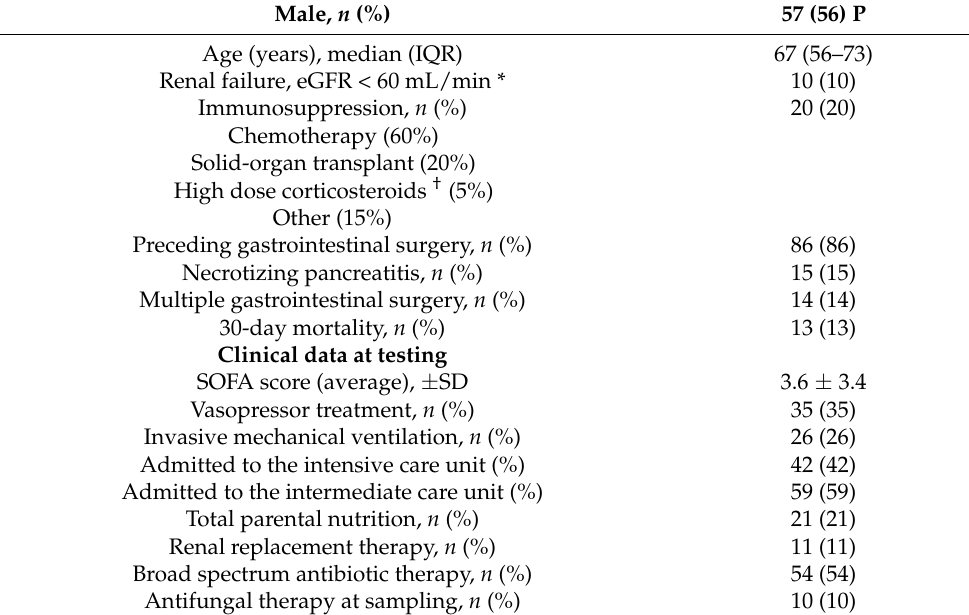
Table 1. Baseline characteristics, n = 101.